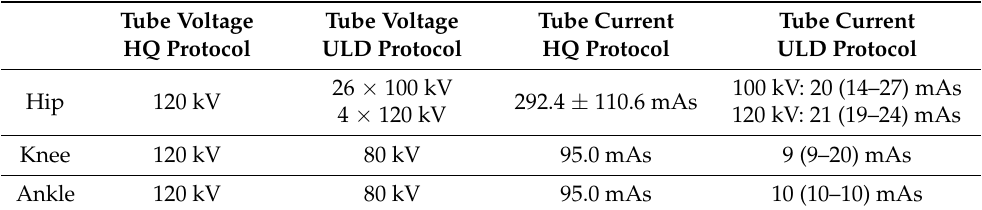
Table 4. Actual acquisition settings of tube voltage and tube current of the HQ protocol and the new ULD protocol in CT-torsion measurement of the lower limb.